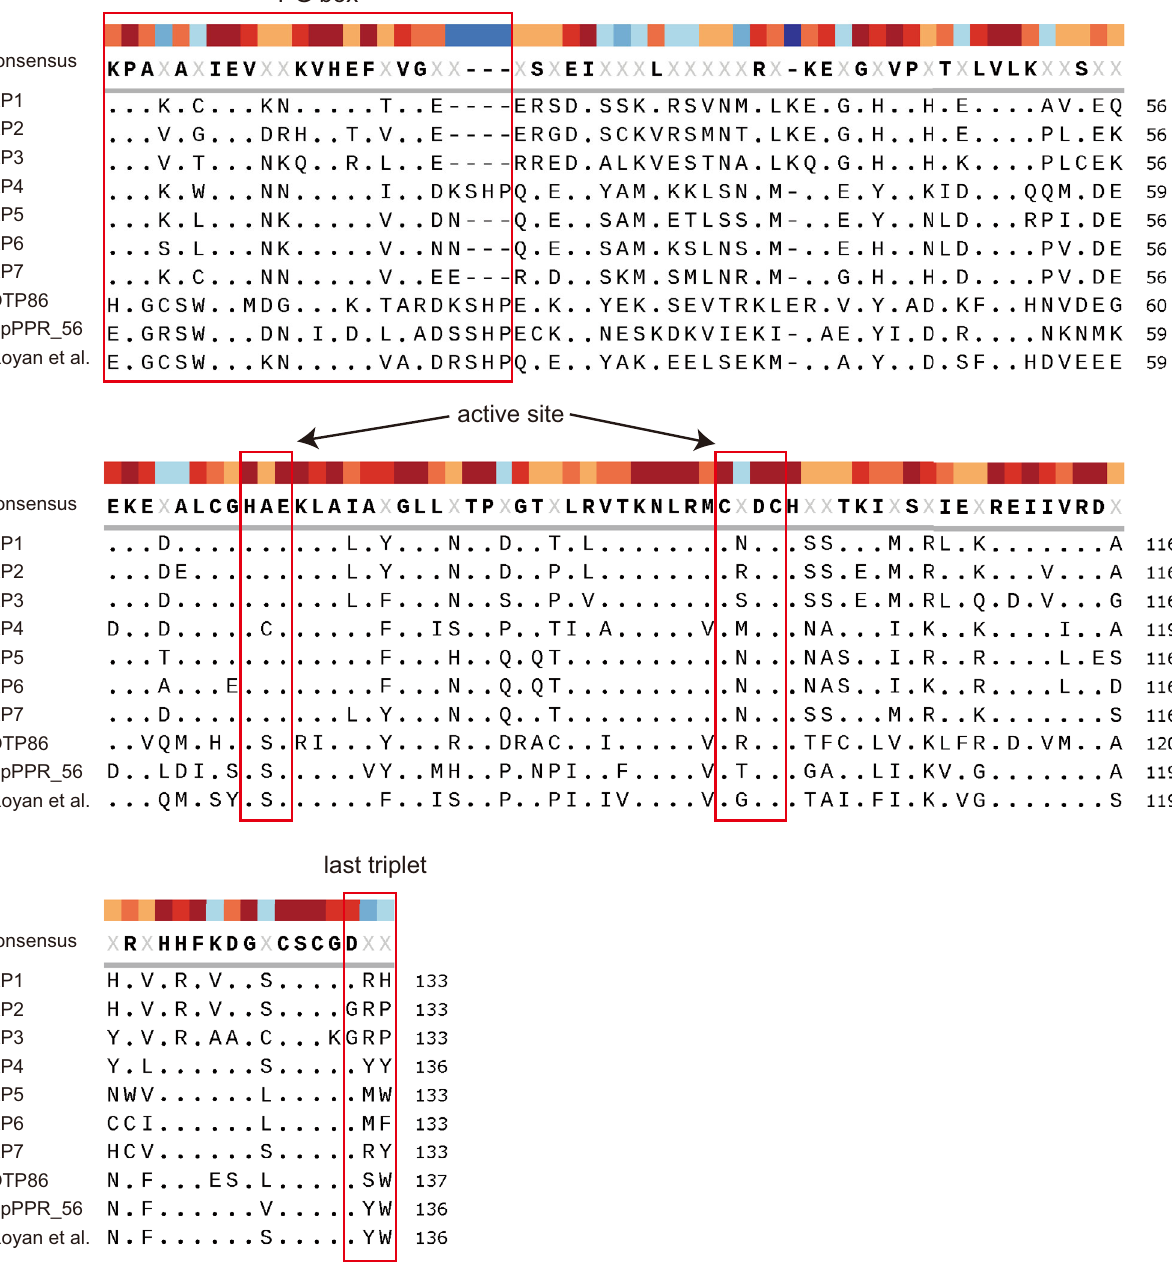
Fig. 2 Comparison of the sequences of designer DYW:KP and DYW:PG domains. The alignment of DYW domains compares seven designer DYW:KP domains with natural DYW:PG domains, OTP86 19,53 , PpPPR_56 20,54 , and a designer DYW:PG domain 6 . The alignment was prepared using MUSCLE 55 . The consensus sequence is shown at the top. Higher conservation is indicated by warm colors (such as brown and red) and lower conservation by cool colors (such as blue). Highly conserved regions in the DYW:PG domain are